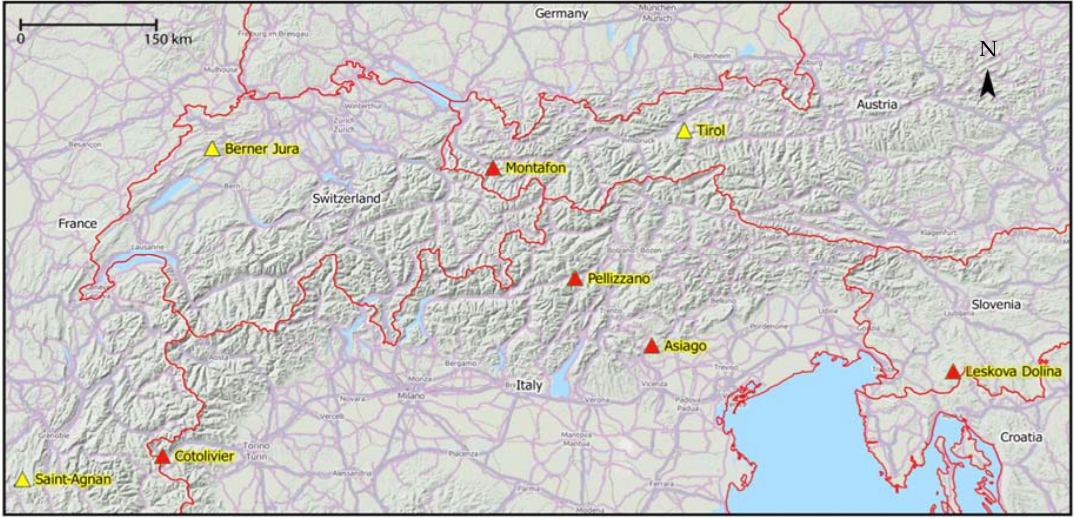
Figure 1. Study areas distribution. Red triangles represent different study areas that this paper used, and yellow triangles represent the remaining areas of NEWFOR (NEW technologies for a better mountain FORest timber mobilization) project.